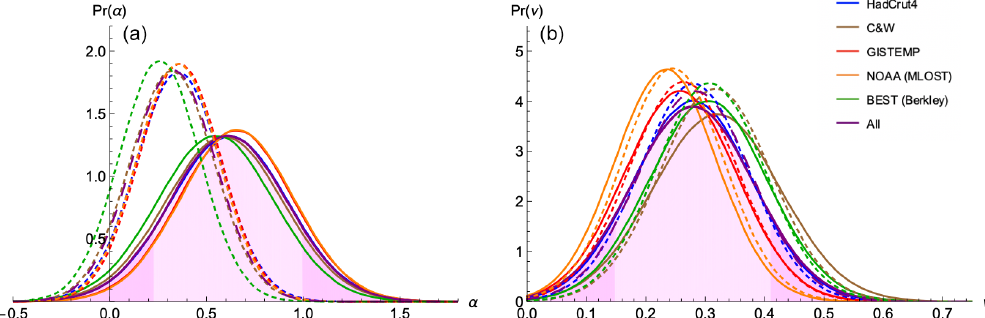
Figure 5. For each observational dataset and their average, PDFs are shown for the forcing parameters: the aerosol scaling factor α (a) and the volcanic intermittency correction exponent ν (b) . Again, shown are the PDFs for parameter estimation based on both F Aer F Aer (dashed). The average PDF of the five observation datasets using F Aer SSP tails.